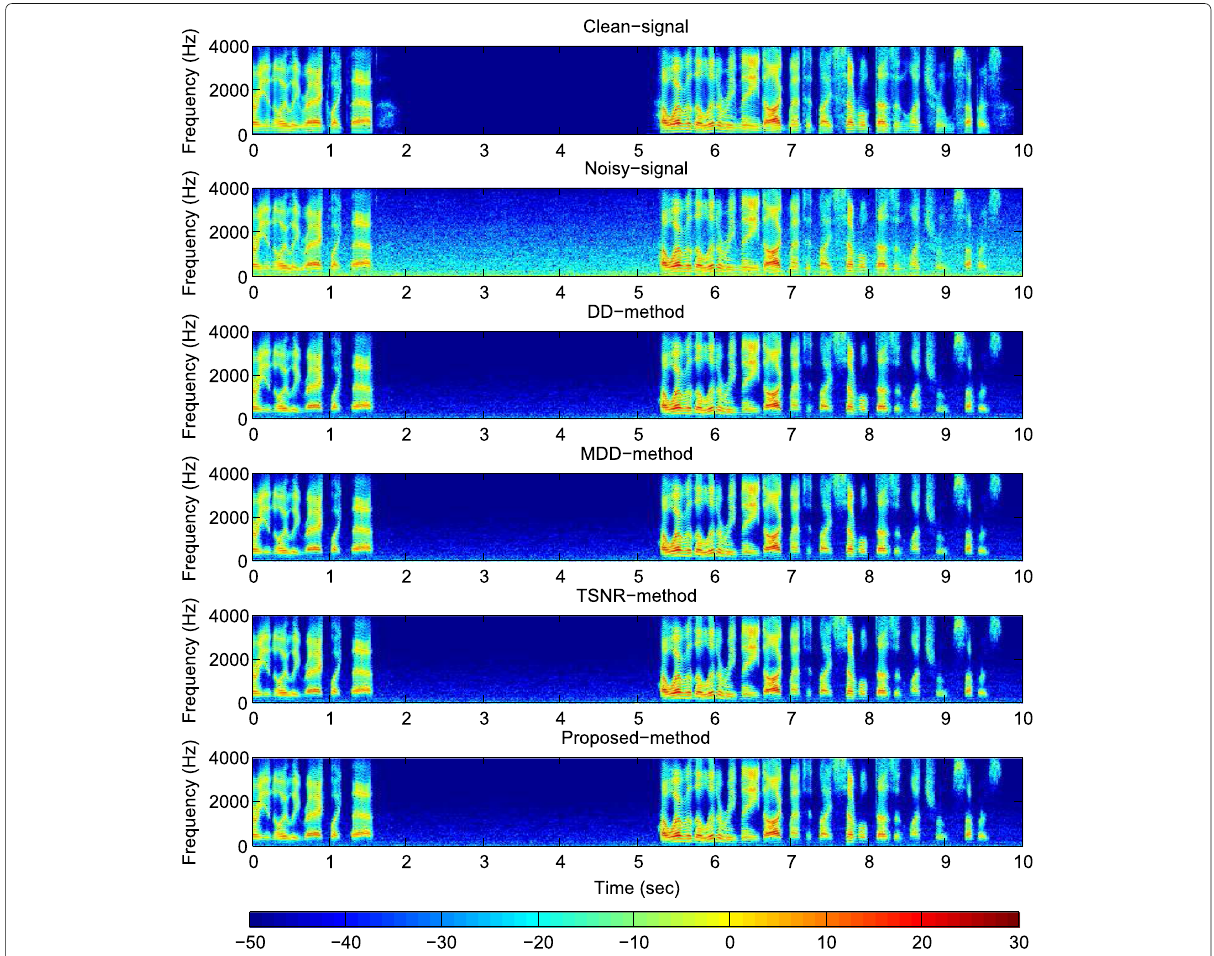
Fig. 8 Speech spectrograms for noisy speech corrupted with factory noise at 10 dB enhanced by WF speech estimation technique